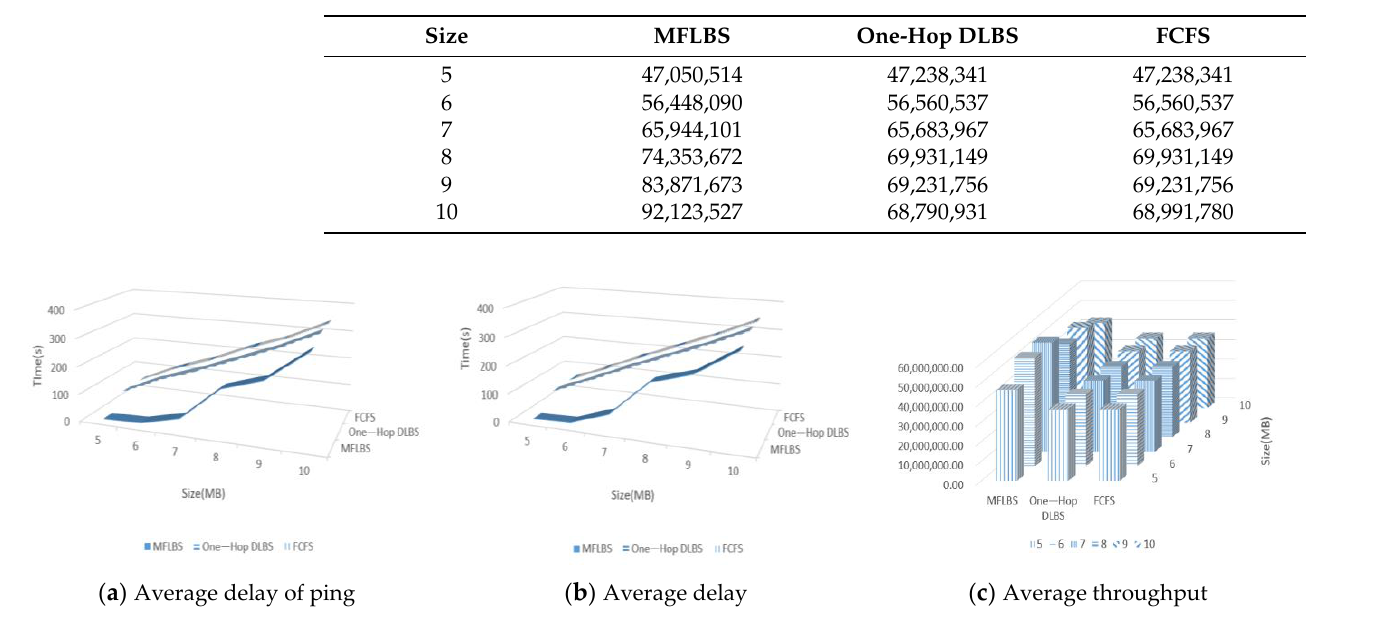
Table 8. Average throughput (MB) in mesh topology under semi-central pattern.